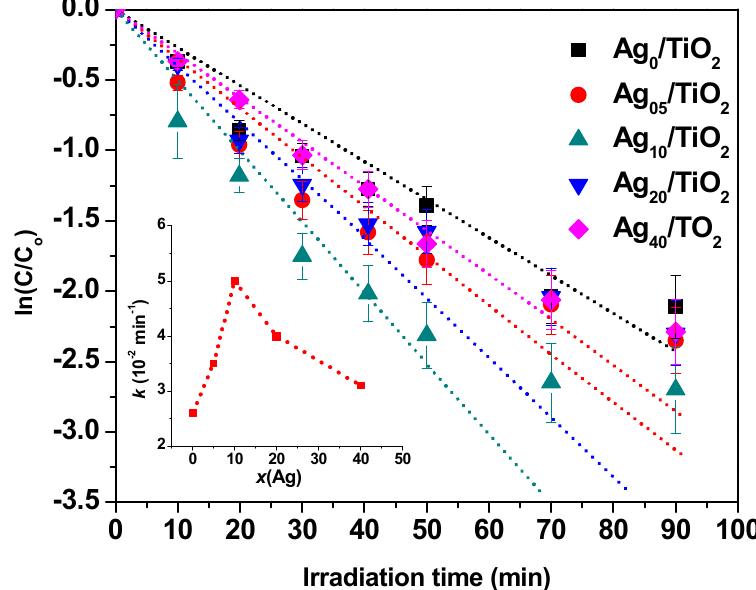
Figure 10. Semi-logarithmic graph of MB concentration versus irradiation time in the presence of Ag x / TiO 2 . The inset shows the first-order reaction rate constants ( k ) versus the Ag concentration.